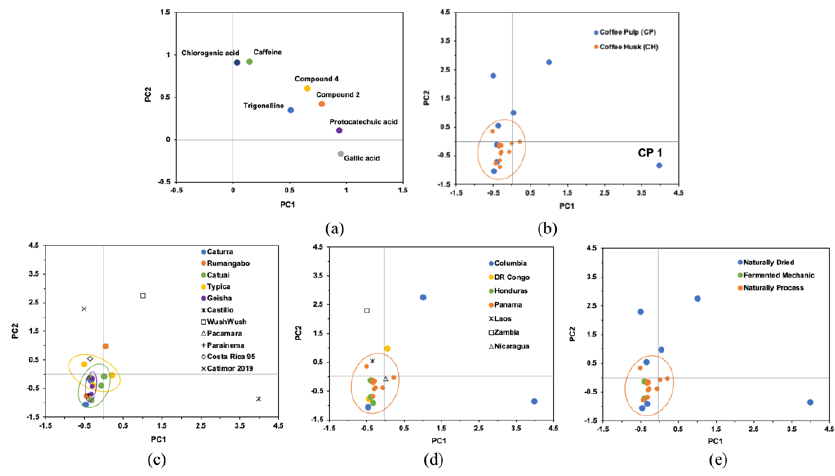
Figure 12. Principal component analysis (PCA) applied to the distribution of phytochemicals ( a ) and coffee cascara pulp and husk samples ( b ), and the visualization of the impact of coffee cultivar ( c ), country ( d ) and process ( e ).